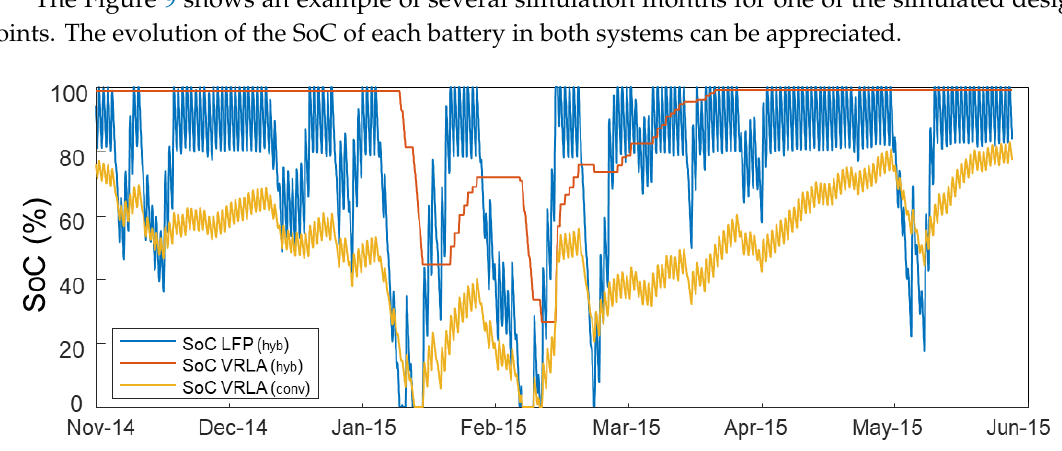
Figure 9. Simulation example for several months with one design Figure 9 . Simulation example for several months with one design point.